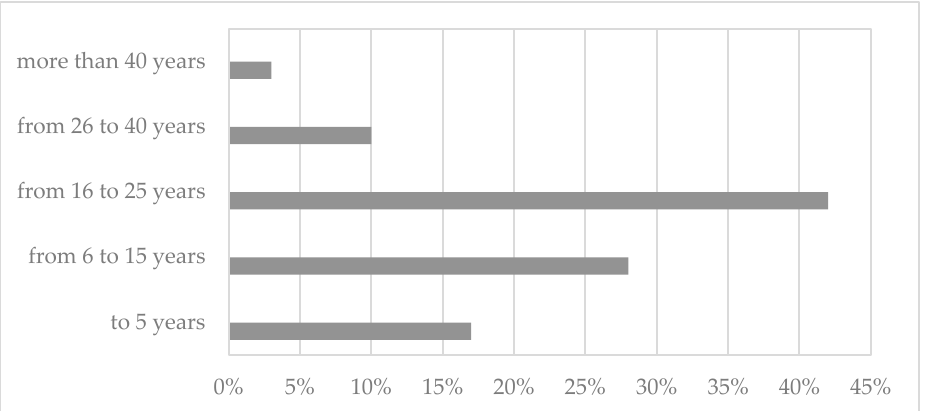
Figure 2. The gas network’s structure age distribution, expressed in % terms.